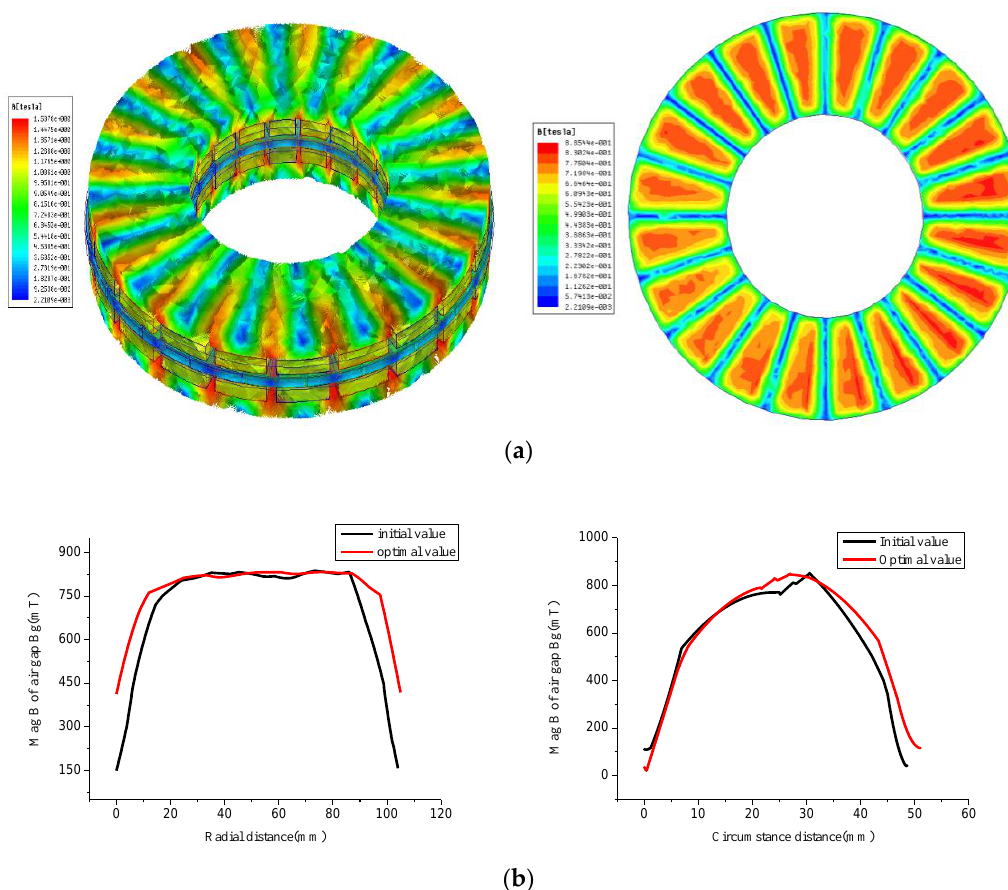
Figure 15. Distribution and comparison of Mag B before and after optimization: ( a ) Magnetic flux density distribution in the APFMSG and on the middle plane of the effective air gap; ( b ) The circumferential distribution curve at average radius and radial distribution curve of Mag B before and after optimization.